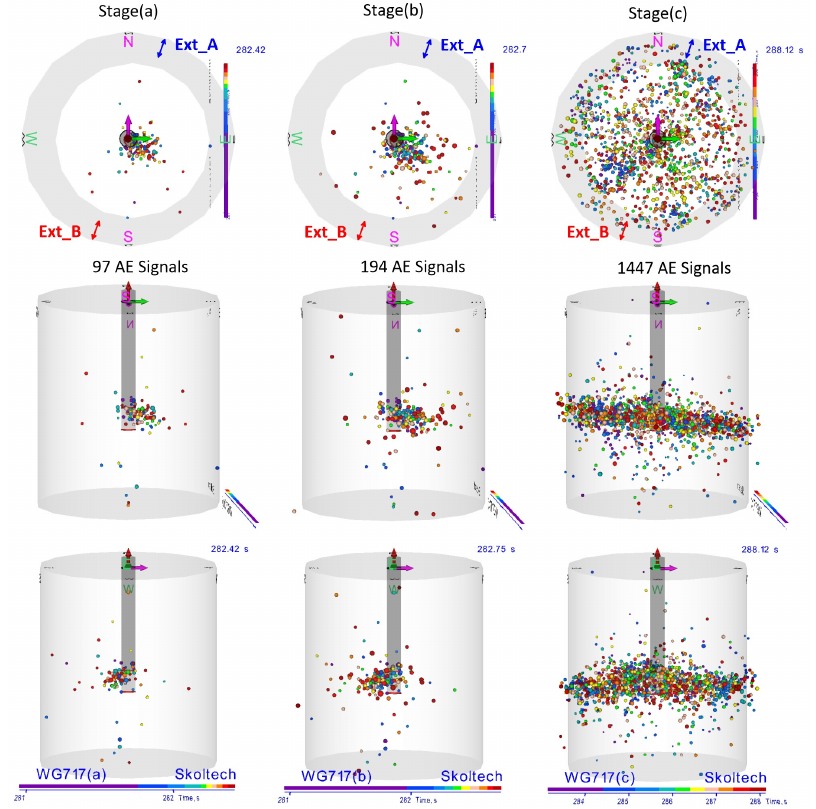
Figure 13. Three orthogonal projections of positions of AE signals in the space of the WG-717 sam-